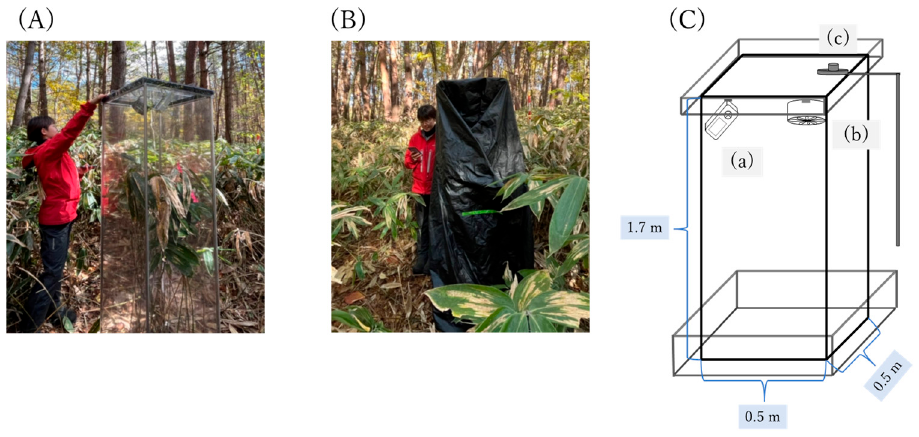
Figure 2. Measurement of the Sasa community GPP under ( A ) 100% light and ( B ) 0% light. ( C ) Schematic illustration of the static chamber system: (a) sensor for CO 2 concentration, temperature, and relative humidity with data logger, (b) mini-fan, and (c) quantum sensor.